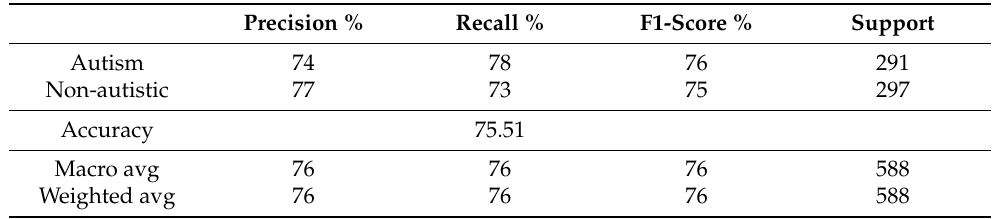
Table 7. Results of VGG-16 with gradient boosting.